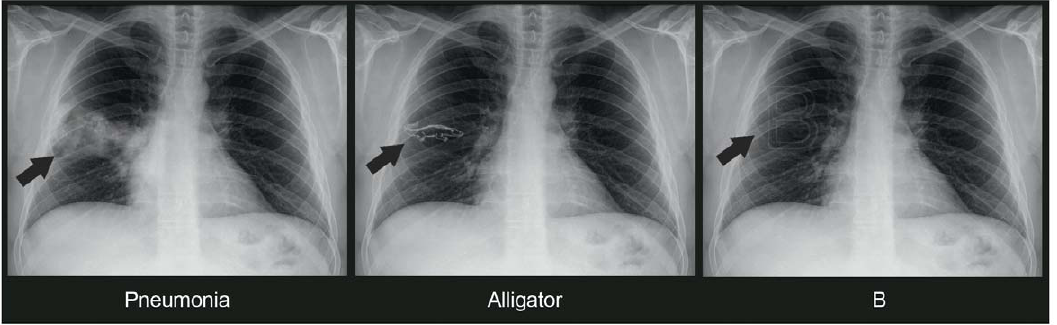
Figure 1. A trio of chest X-ray images with pairing of a lesion, an animal, and a letter*. *Arrows pointing to targets in the image; not present in the original images.